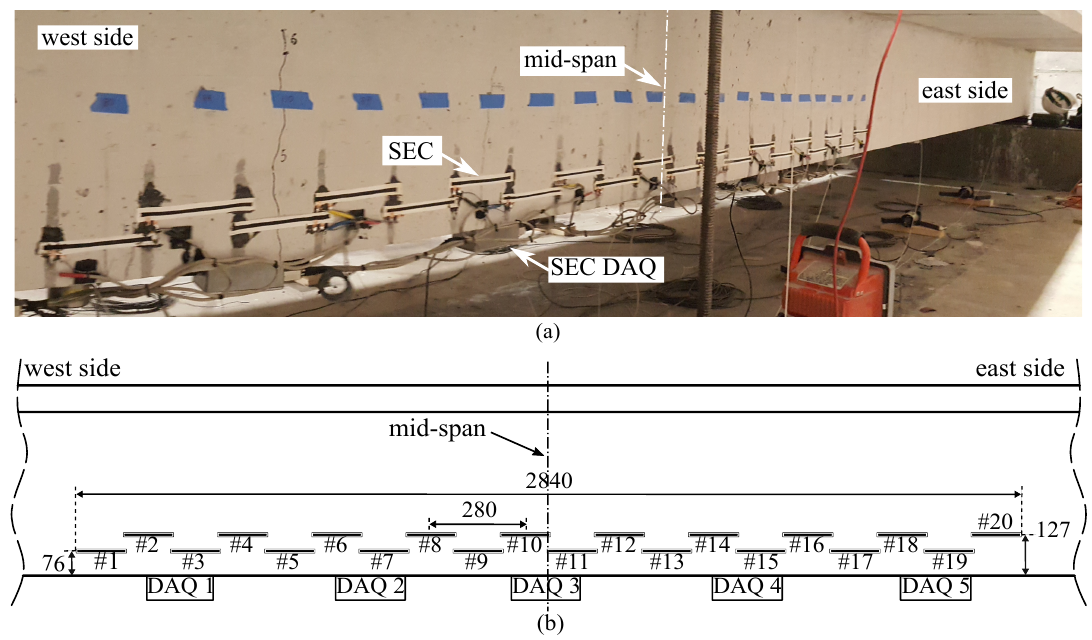
Figure 8. Sensor instrumentation around the midspan of the beam: ( a ) picture; and ( b ) schematic of sensor locations, partial beam elevation (dimensions are in